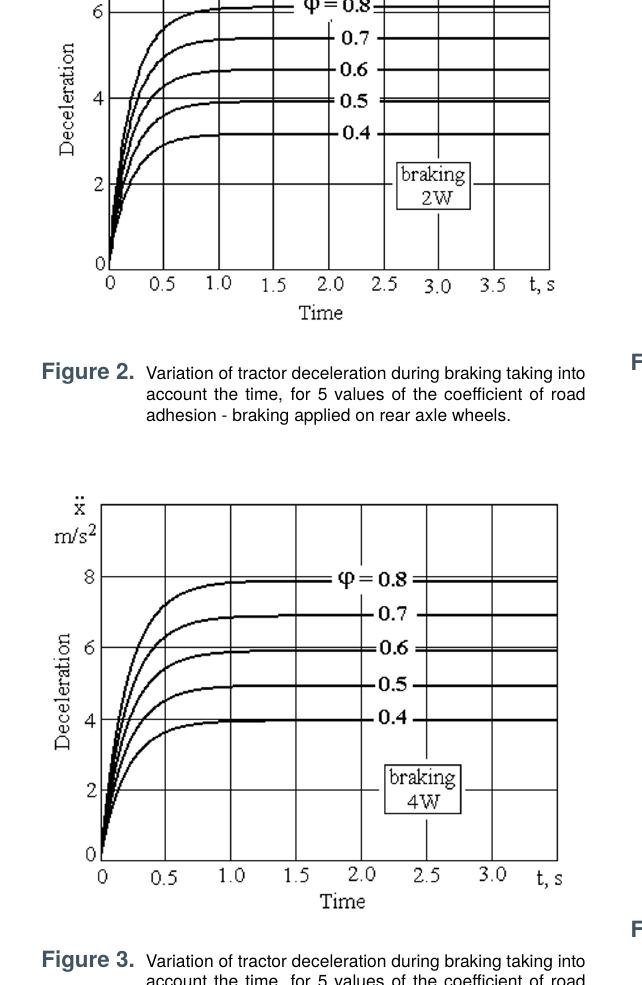
Figure 3. Variation of tractor deceleration during braking taking into account the time, for 5 values of the coefficient of road adhesion - braking applied on all wheels.